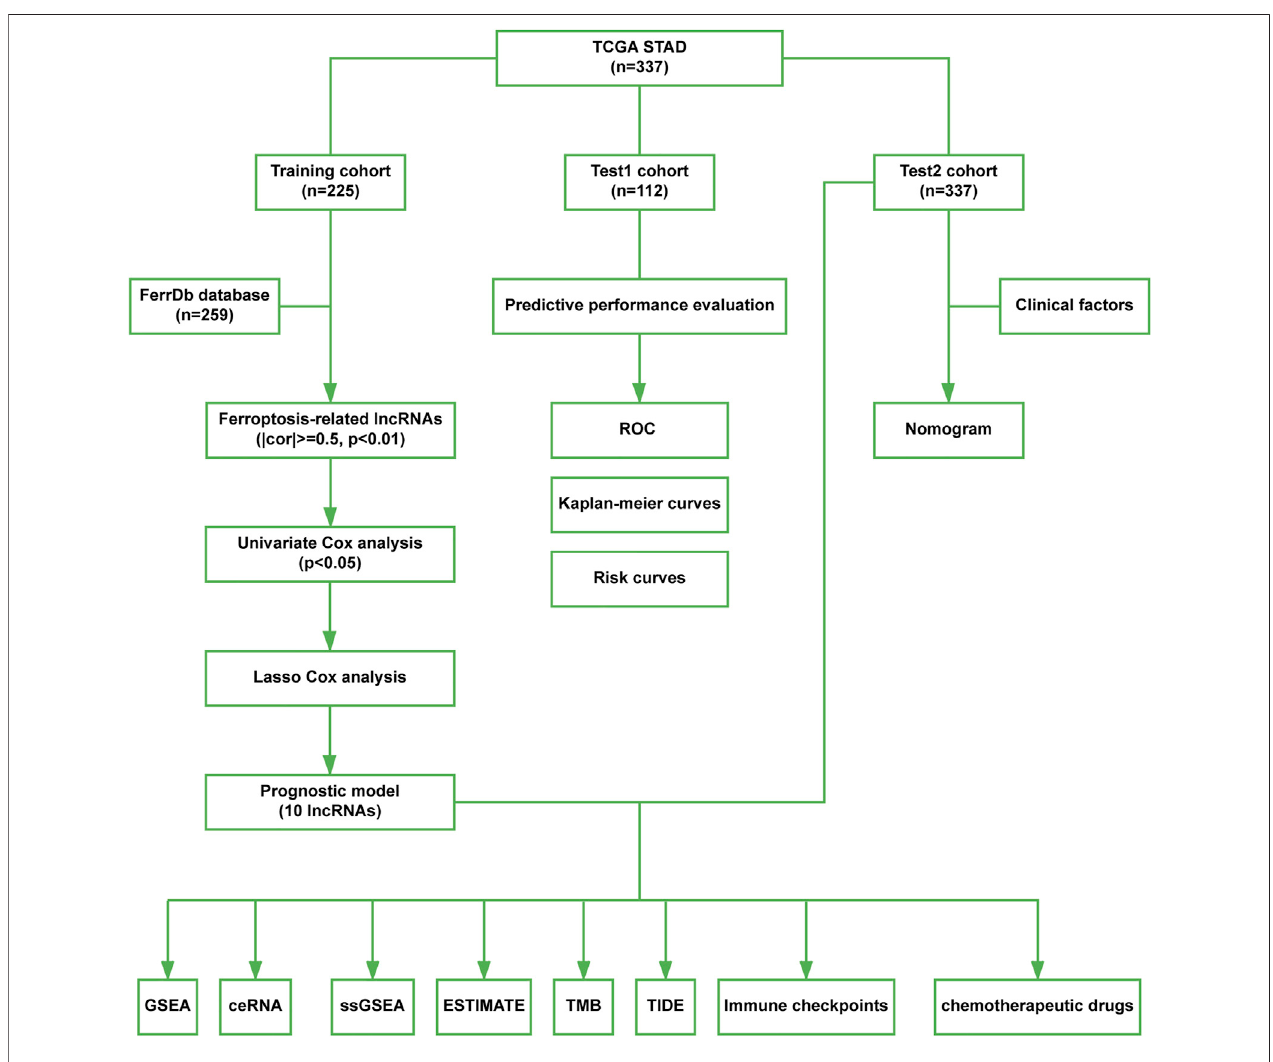
FIGURE 1 | The fl ow chart in this